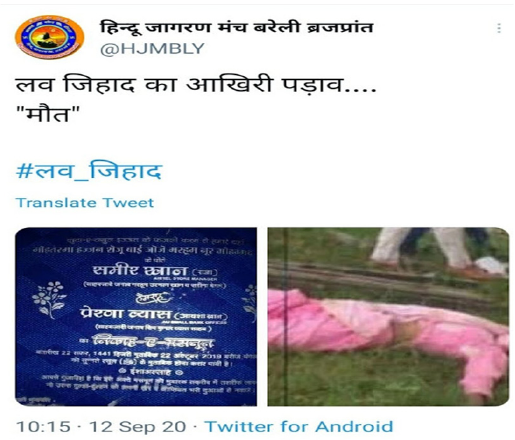
Figure 13. Tweet by Hindu Jagran Manch included two unrelated images with the caption “death” is the last stage of love jihad.